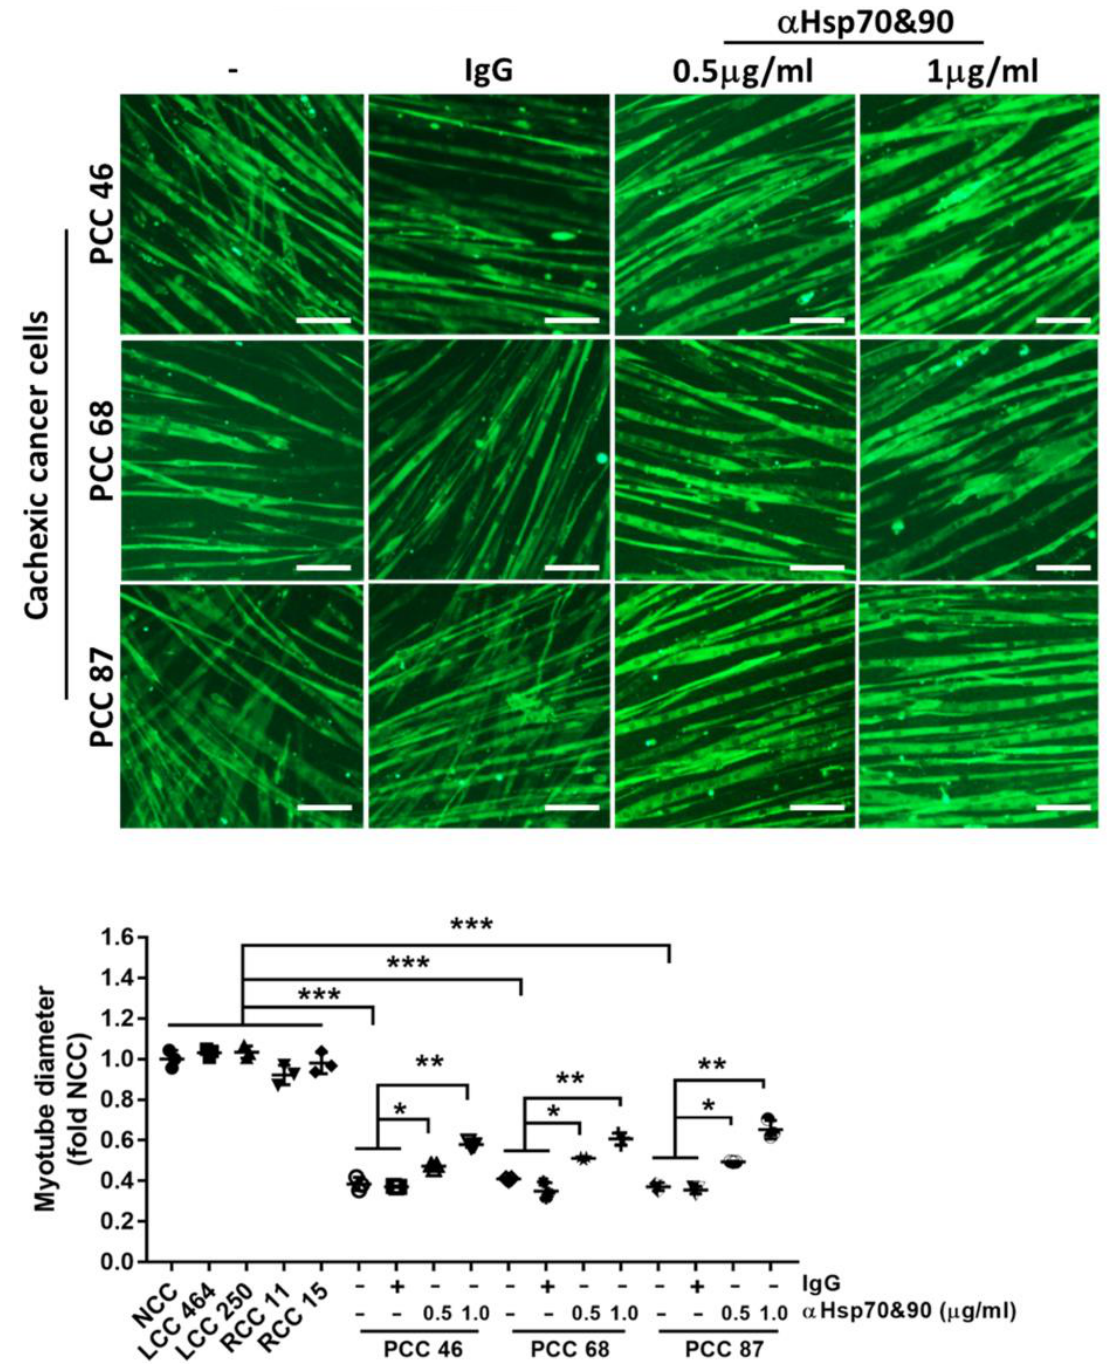
Figure 4. Conditioned medium of PCC causes myotube atrophy in an Hsp70- and Hsp90-dependent manner. C2C12 myotubes were treated as described in Figure 3 for 72 h. Myotubes were subjected to immunofluorescence staining of MHC. The myotube diameter was measured. Bar = 100 µ m. Three independent experiments ( n = 3) were carried out. Data were analyzed by one-way ANOVA followed by Bonferroni’s multiple comparison test. * denotes p < 0.05, ** denotes p < 0.01 and *** denotes p < 0.001.